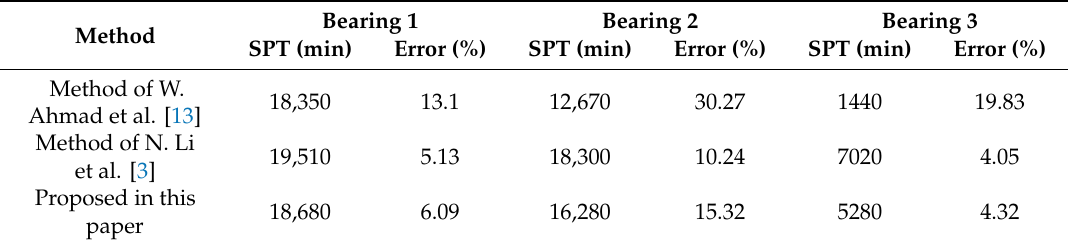
Table 2. SPT determination results and the corresponding prediction